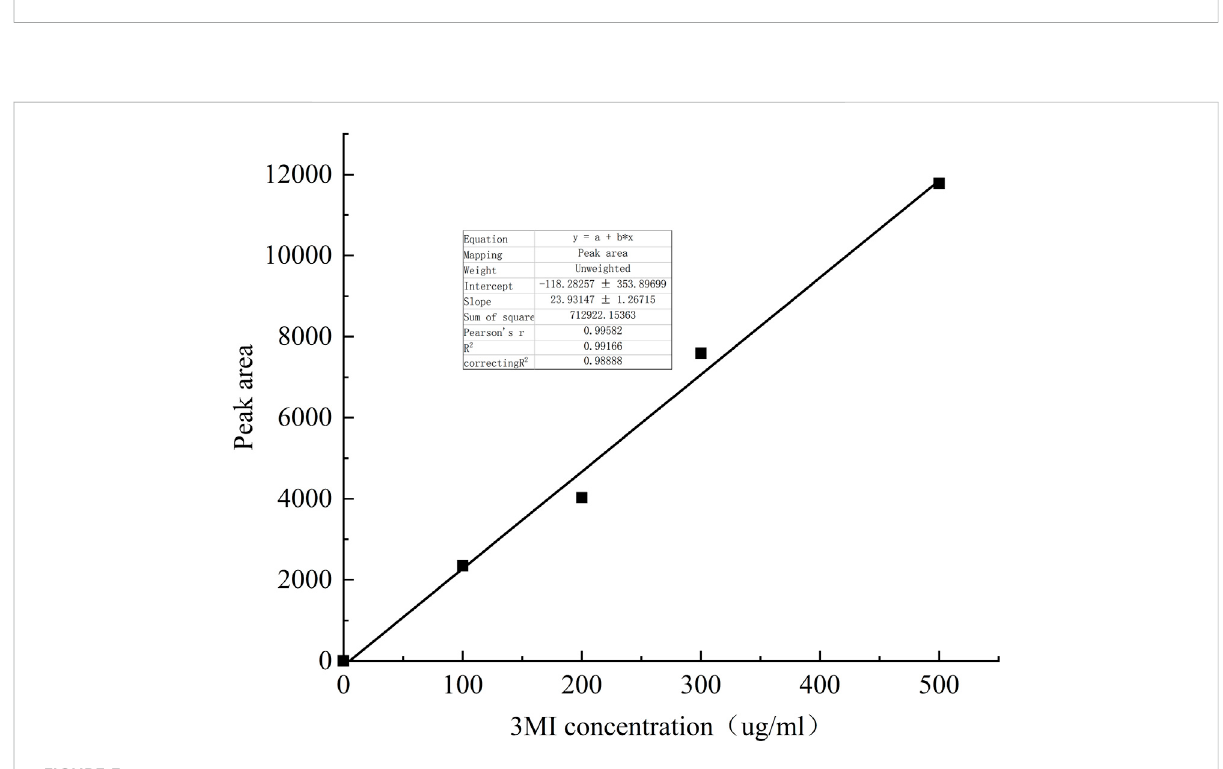
FIGURE 3 3MI liquid